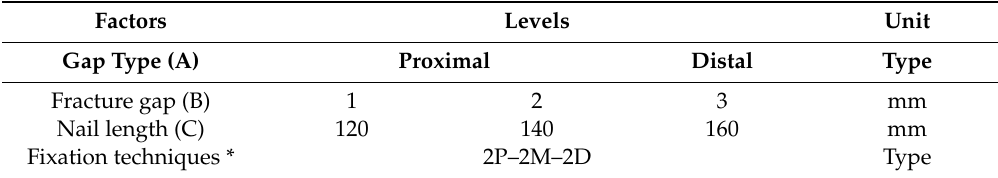
Table 4. Four locking screws: the multilevel factorial design of relevant factors and their levels. (Number of levels: 3, 3, 3, and 4.) .